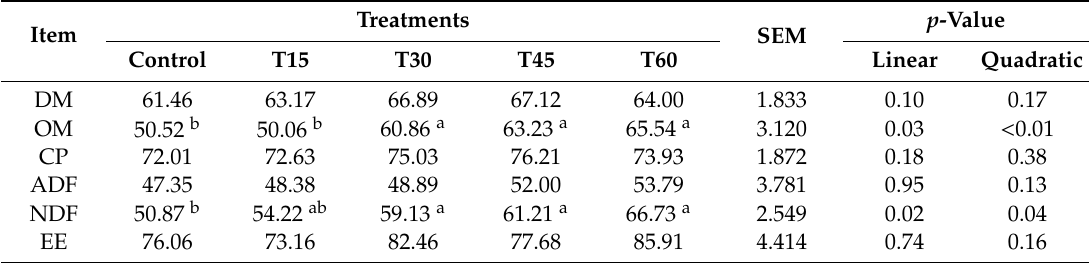
Table 3. Apparent digestibility of nutrients of fattening Hu sheep fed with mulberry leaf powder